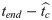

tend-tc^ plane.The six possible regimes associated with the different relationships between tend, Tc and tc^ are depicted. The true time Tc at which the bubble bursts is indicated by the red dashed horizontal and vertical lines.